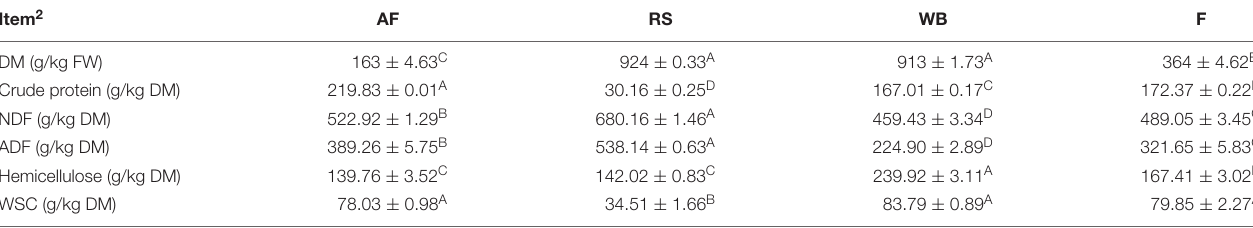
TABLE 1 | Mean (SEM 1 ) chemical composition before ensiling (n = 3 samples).